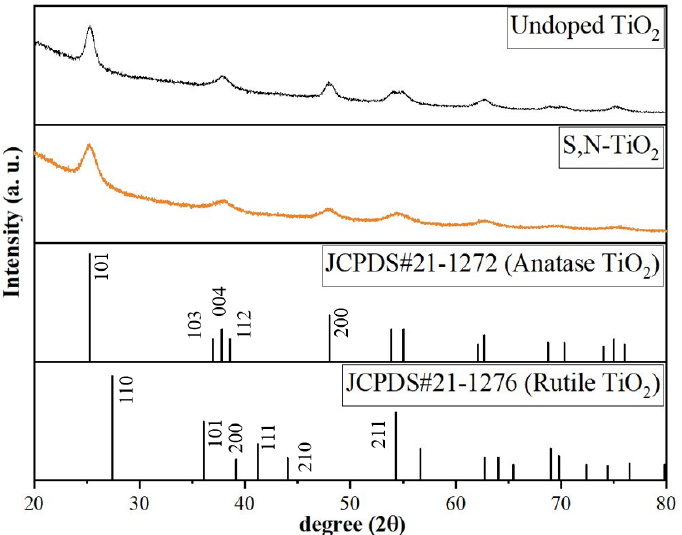
Figure 5. XRD patterns of undoped TiO 2 and codoped S,N-doped TiO 2 photocatalyst powders. The XRD pattern of the anatase phase of TiO 2 (JCPDS card number 21-1272) and the rutile phase of TiO 2 (JCPDS card number 21-1276) are also provided for comparison purposes (bottom patterns).